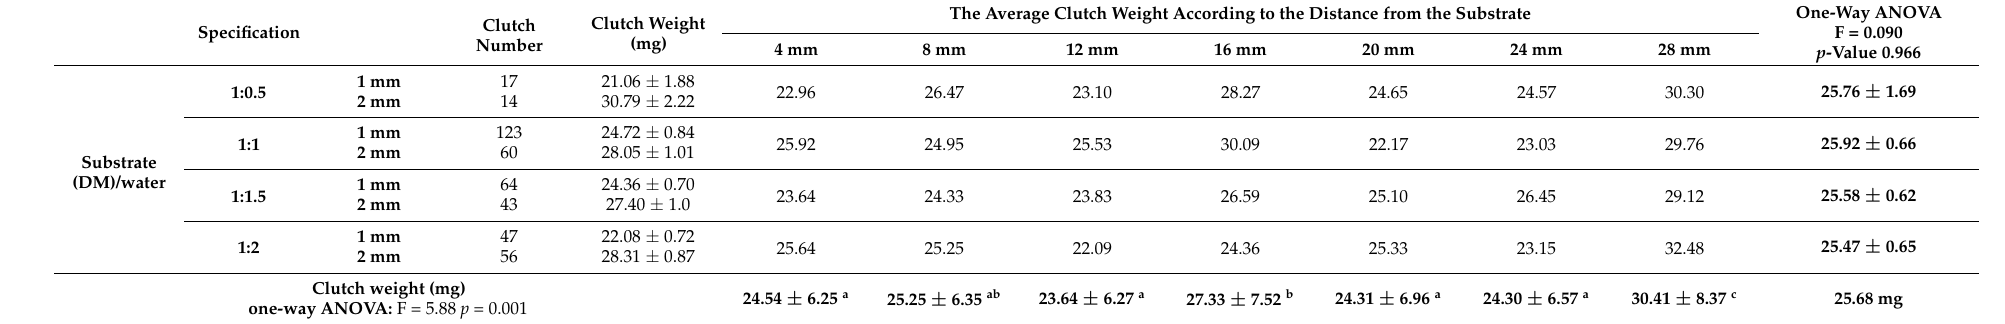
Table 3. Influence of substrate moisture and slot size, correlated with ovipositing distance from the substrate, on the clutch weight. The Average Clutch Weight According to the Distance from the Substrate One-Way ANOVA Specification